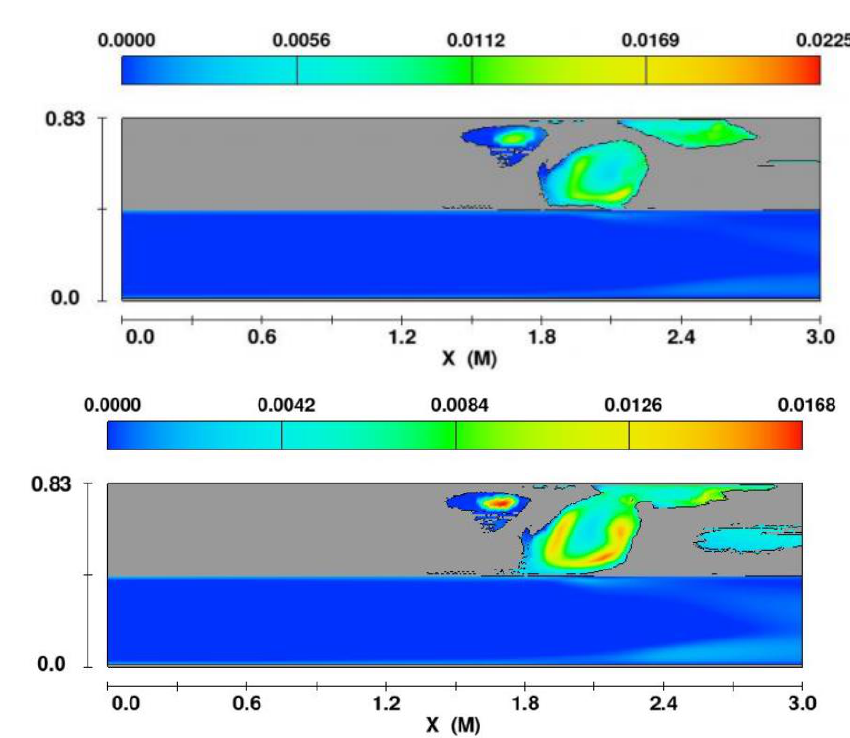
Figure11. Turbulent kinetic energy in downstream of side weir in side